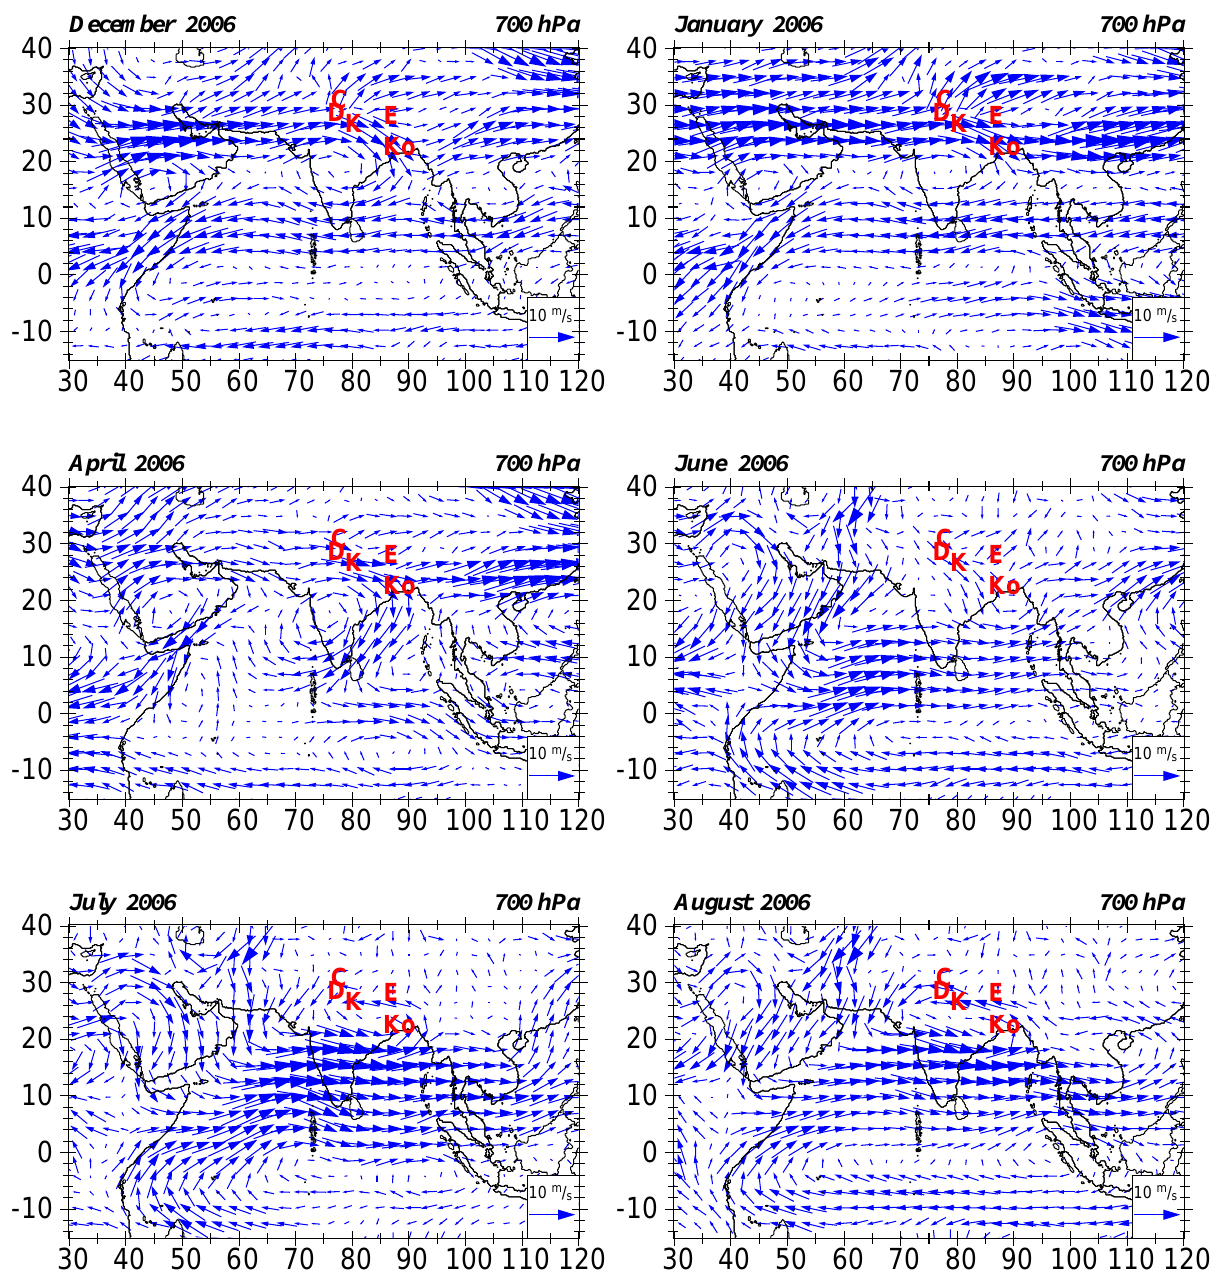
Fig. 37. Wind vector fields over southern Asia at 700hPa for selected months in 2006, based on NCEP-GFS data, focusing particularly on the flow to the Himalayas, marked by ”E” for Mt. Everest. Labeled cities in the Indo-Gangetic Plain are: C – Chandigarh; D – Delhi; K – Kanpur; Ko – Kolkata